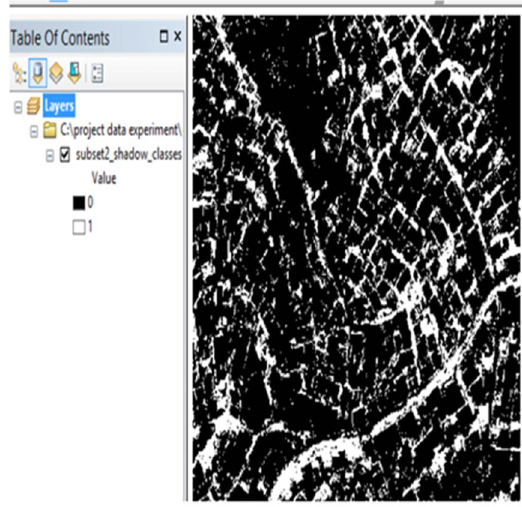
Figure 10: NDVI image after thresholding. 4.3 Shadow Free Vegetation Image The shadow free vegetation image was determined by masking out objects identified as shadows from the NDVI binary image. After the shadow objects were removed, the final output was turned into an image without shadow.